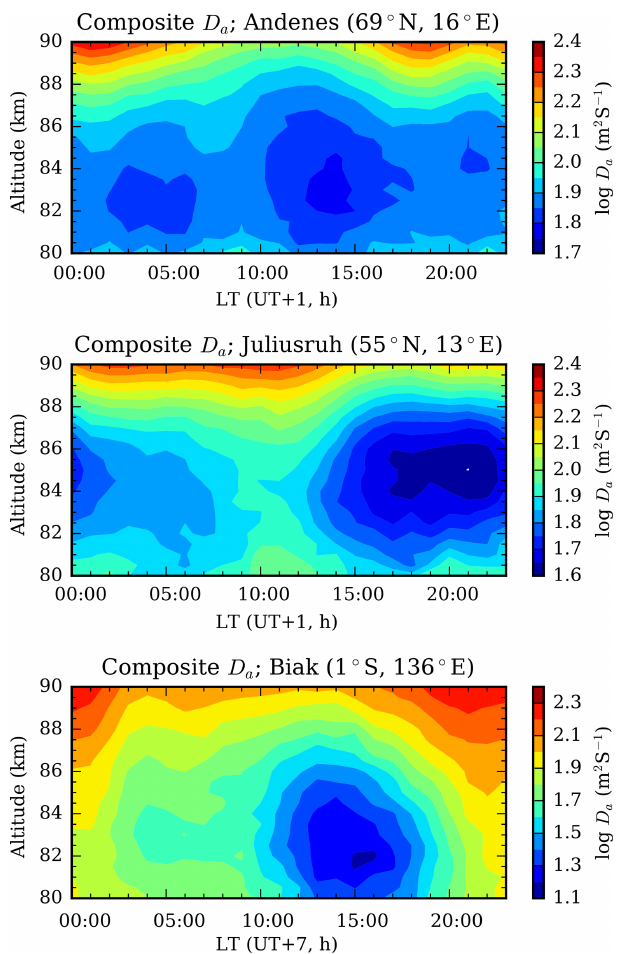
Figure 4. Composite D a during June–July of the years 2012–2016, excluding the year 2014, over the three stations. It clearly shows that the semi-diurnal tide is the dominant tide at high latitudes and diurnal is dominant at low latitudes, while at midlatitudes it seems mixed. This signifies that MTD variation has a strong tidal variabil- ity.